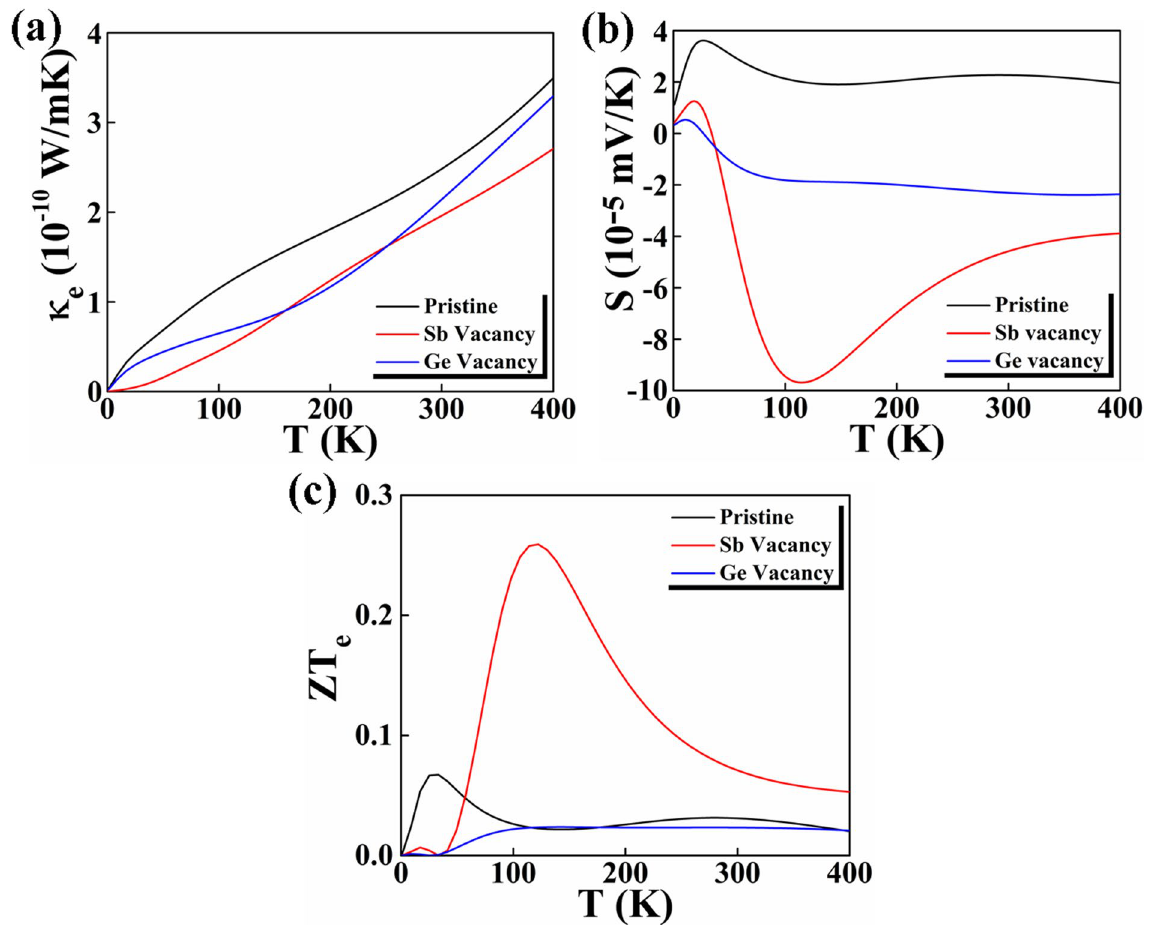
Figure 5. ( a ) Calculated electronic thermal conductivity, ( b ) Seebeck co-efficient and ( c ) figure of merit (ZT e ) of the pristine Sb/Ge NW, the Sb/Ge NW with the Sb vacancy and the Sb/Ge NW with the Ge vacancy as functions of